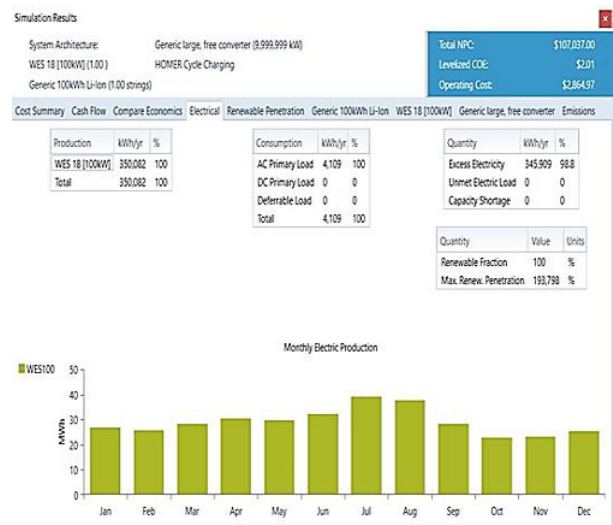
Fig. 2. The results by HOMER of WES 18 - 100KW.